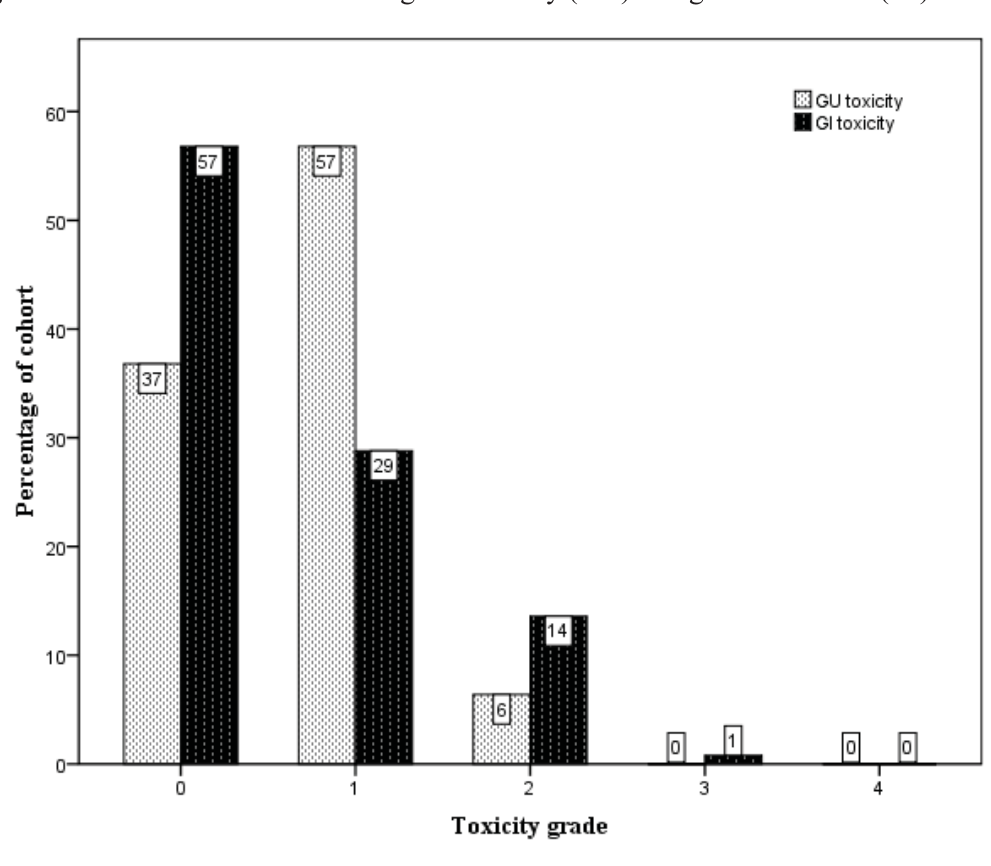
Figure 2. Crude incidences of acute genitourinary (GU) and gastrointestinal (GI) toxicity.